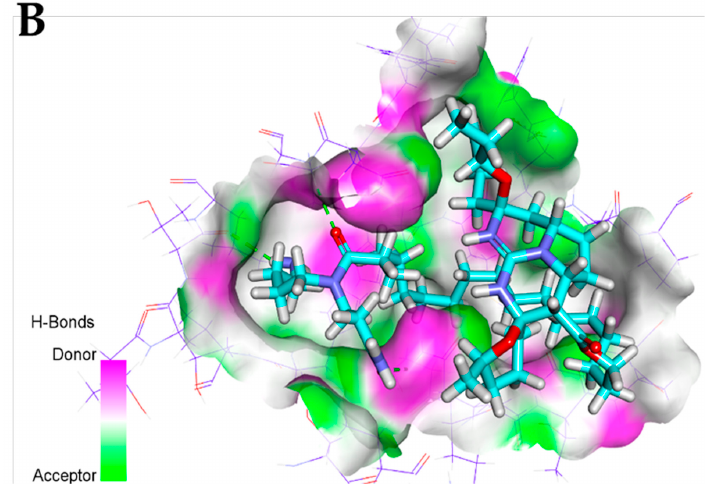
Figure 11. ( A ) Compound 13 docked into the active site of COVID-19 main protease. ( B ) Mapping surface showing compound 13 occupying the active pocket of COVID-19 main protease.